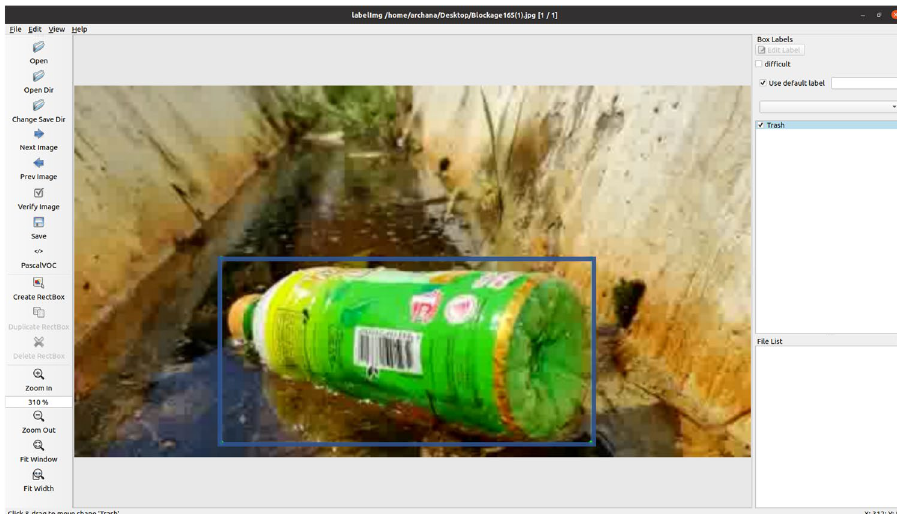
Figure 7. Bounding Box annotation tool.